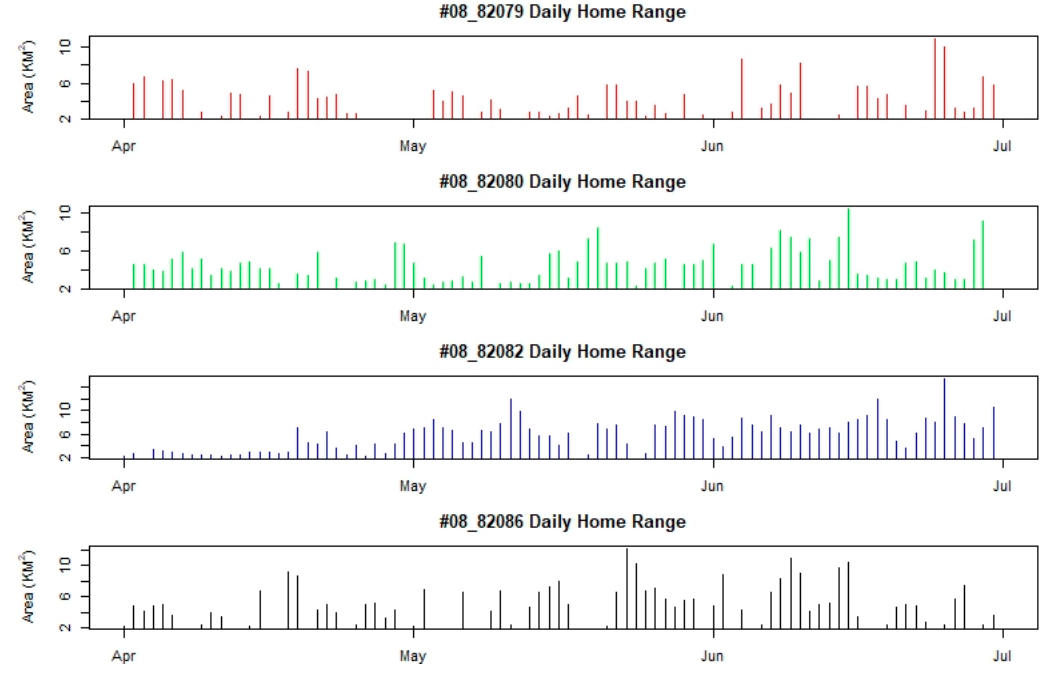
Figure 5. The dynamic change of daily home range sizes (km 2 ) of four Bar-headed Geese ( Anser indicus ) marked and satellite-telemetry tracked at Qinghai Lake in 2008. Birds 08_82082 and 08_82086 are female while 08_82079 and 08_82080 are male.